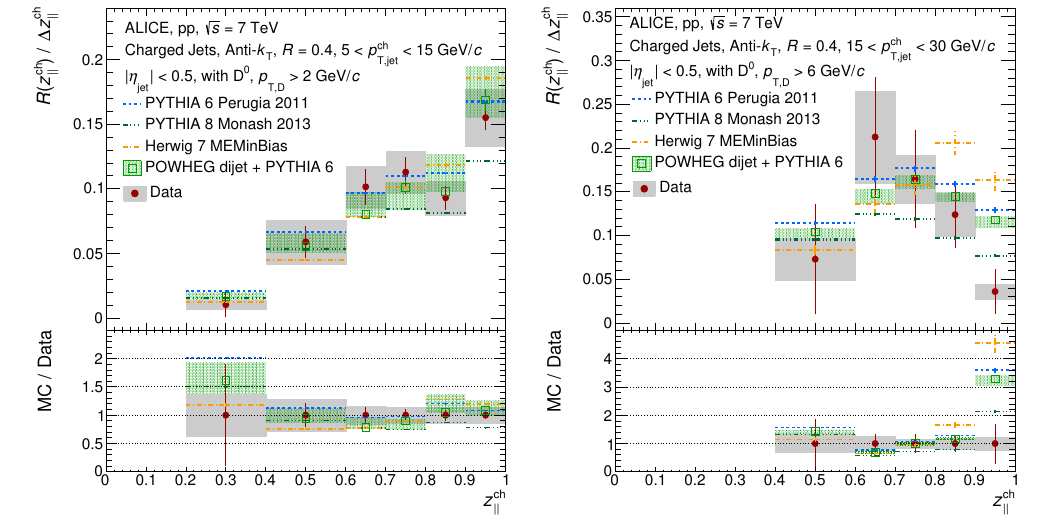
Figure 8 . Rate of D 0 -meson tagged track-based jets as a function of the jet momentum fraction p carried by the D 0 mesons in the direction of the jet axis in pp collisions at s = 7 TeV with 5 < p ch < 15 GeV =c (left) and 15 < p ch < 30 GeV =c (right). The solid red circles show the data T ; jet T ; jet with their systematic uncertainties represented by gray boxes. The measurements are compared with PYTHIA 6 Perugia 2011 (blue), PYTHIA 8 Monash 2013 (green dashed lines), the POWHEG di-jet implementation (open squares) and Herwig 7 MEMinBias (orange).